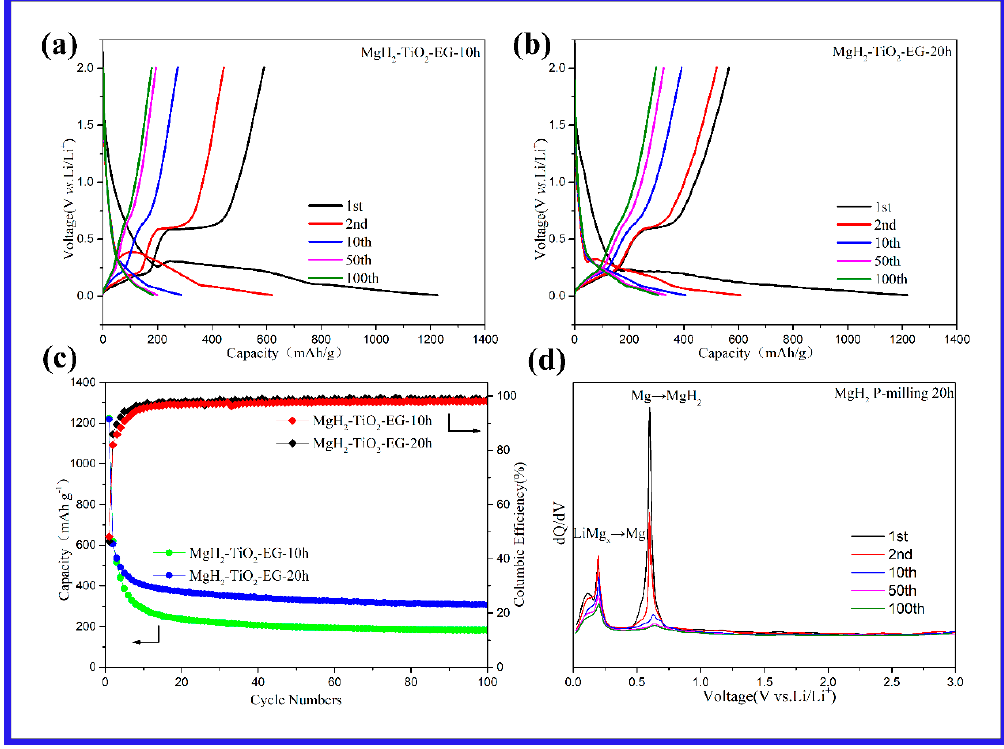
Figure 3. Discharge/charge curves of ( a ) MgH 2 –TiO 2 –EG-10 h and ( b ) MgH 2 –TiO 2 –EG-20 h electrode at a current rate of 100 mA·g − 1 ; ( c ) cycling performance of MgH 2 –TiO 2 –EG electrodes; ( d ) differential capacity plots (dQ/dV) of MgH 2 –TiO 2 –EG-20 h electrode at different cycles.